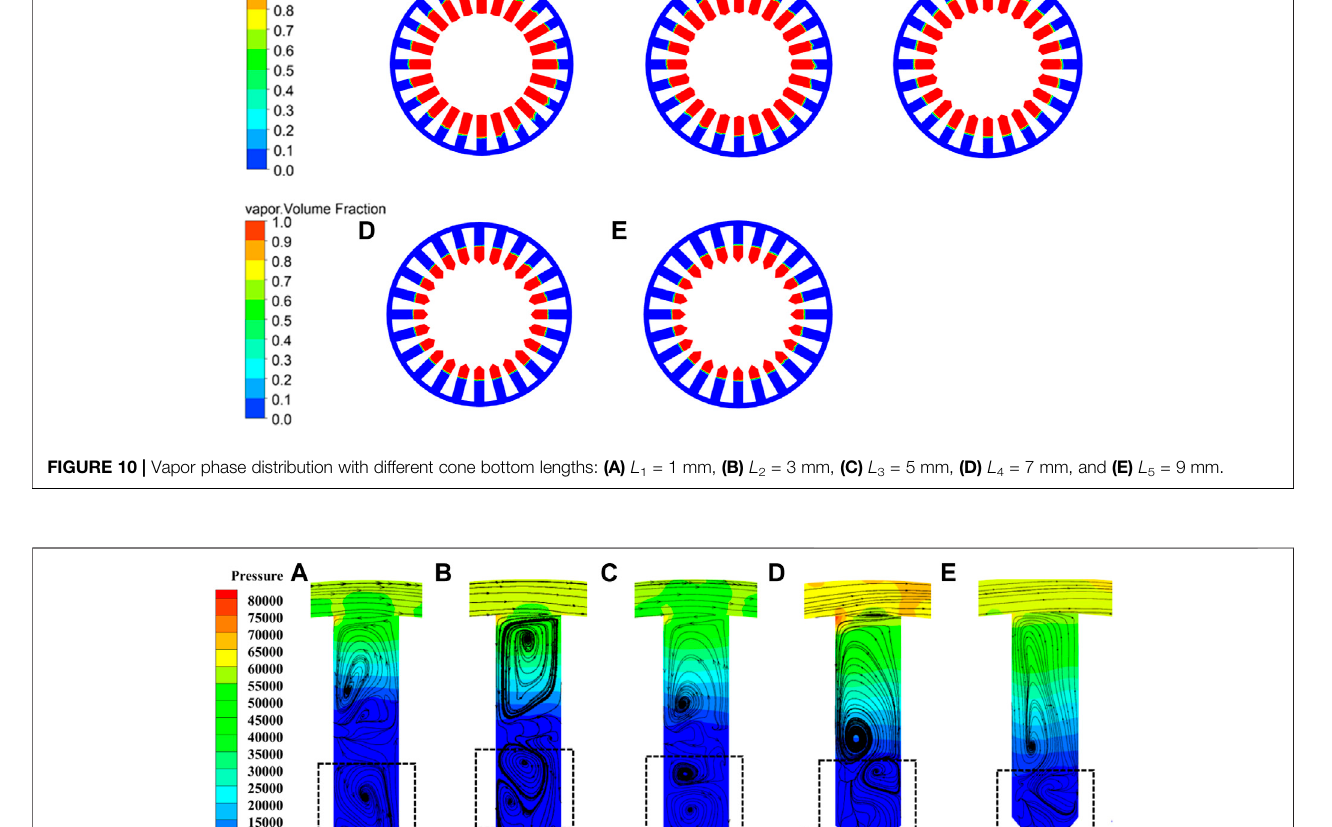
With the increase of the cone bottom length, the low- pressure region reduces, and the vortex intensity near the hole bottom also weakens. The vortex number varies under